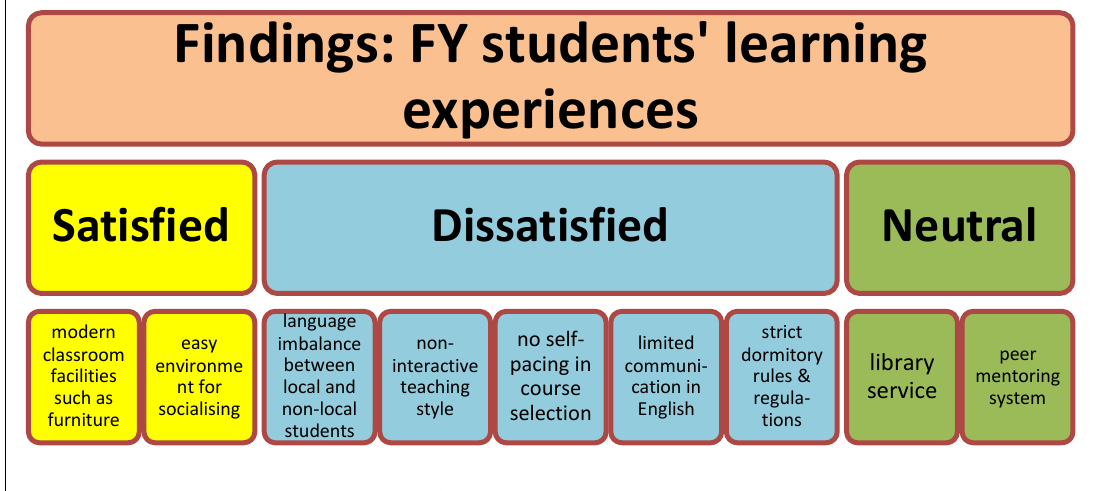
Figure 4. Findings of FY students’ learning experiences at a private university in